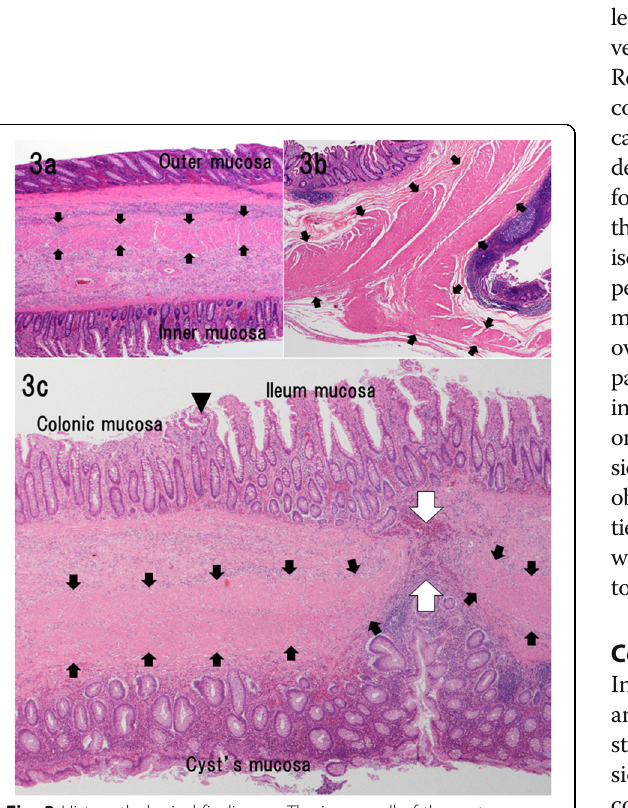
Fig. 3 Histopathological findings. a The inner wall of the cyst was lined with colonic mucosa, and it shared a muscle layer (arrows) with the original enteric wall. b The muscular layer (arrows) was separated into two layers at the edges of the cyst. c A vestige of the opening site in the cyst wall: a discontinuity (white arrows) of the cyst ’ s muscle layer (black arrows) was observed at the top of the cyst near the transitional point (arrowhead) between the ileum and colonic